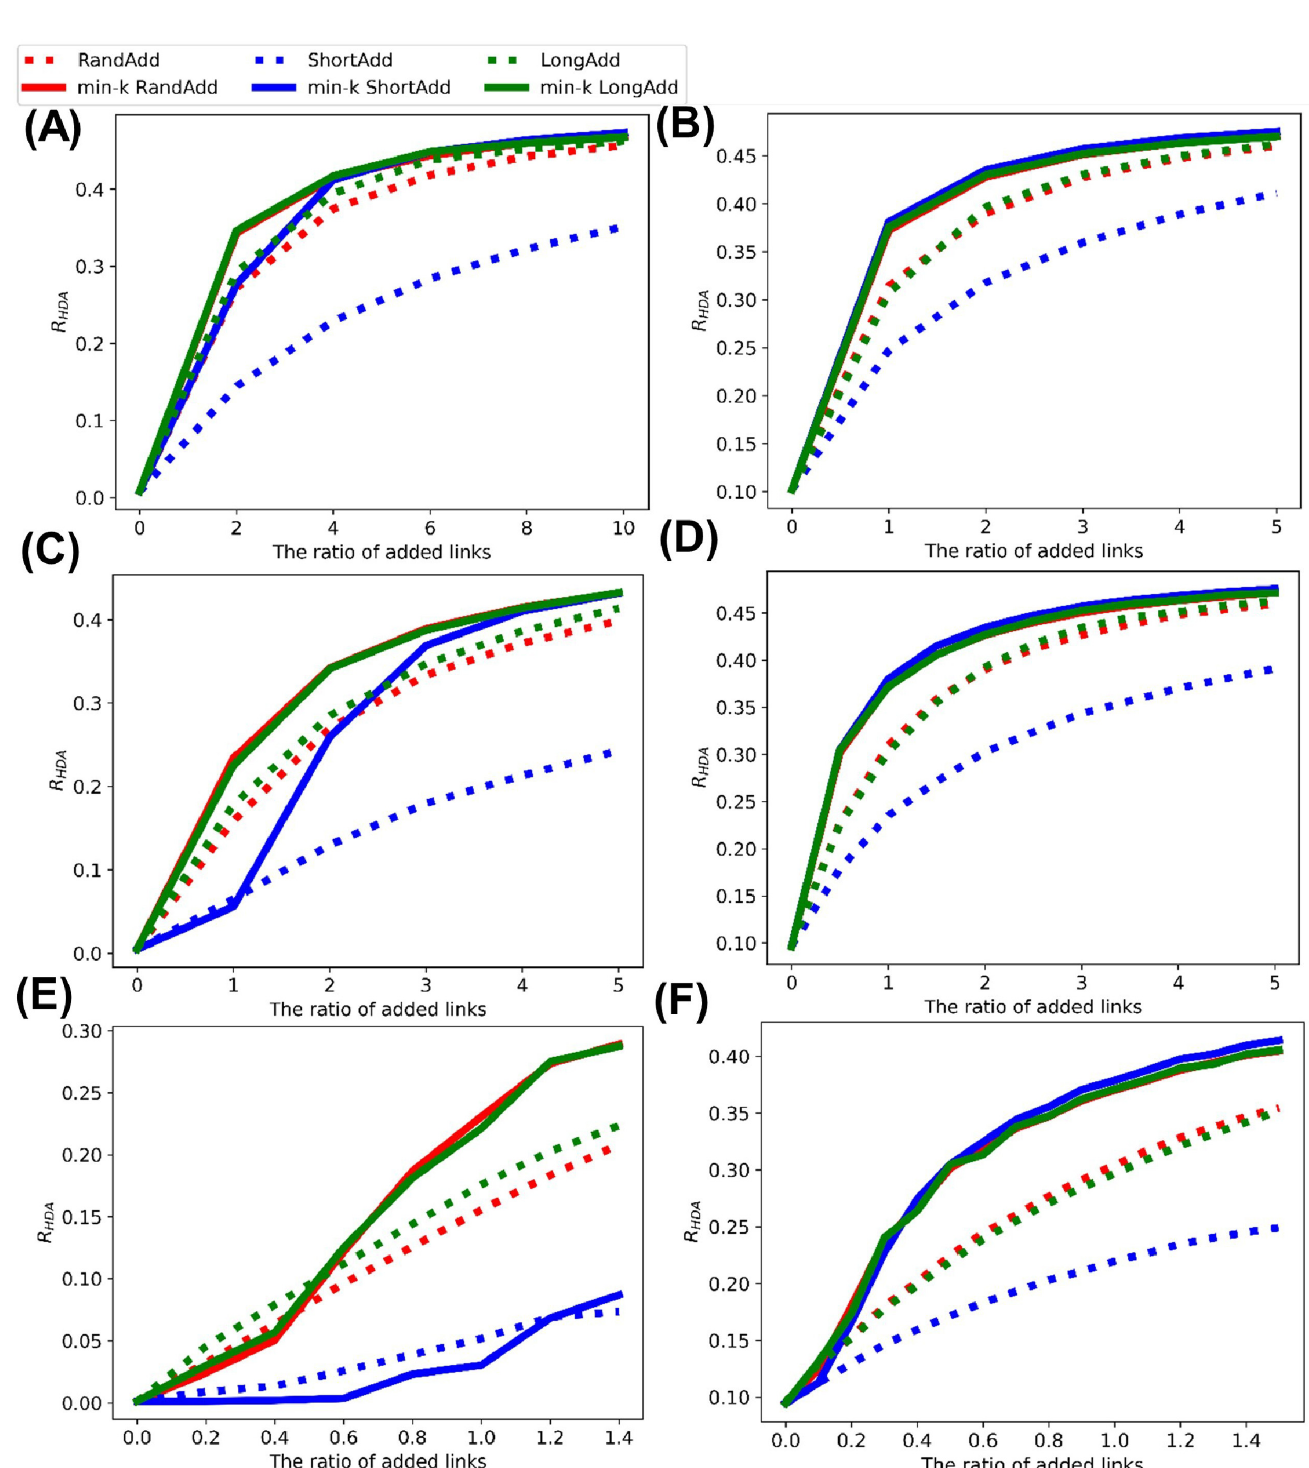
Fig 5. Robustness index against typical HDA attacks after adding links to SF networks. The min- k RandAdd and min- k LongAdd methods (red and green solid lines) are effective for SF trees, while the min- k RandAdd, min- k ShortAdd, and min- k LongAdd methods (three solid lines) are effective for non-tree SF networks. The initial SF networks are trees with (A) N = 500, (C) 1000, or (E) 5000, and are non-trees with (B) N = 500, (D) 1000, or (F) 5000 nodes.